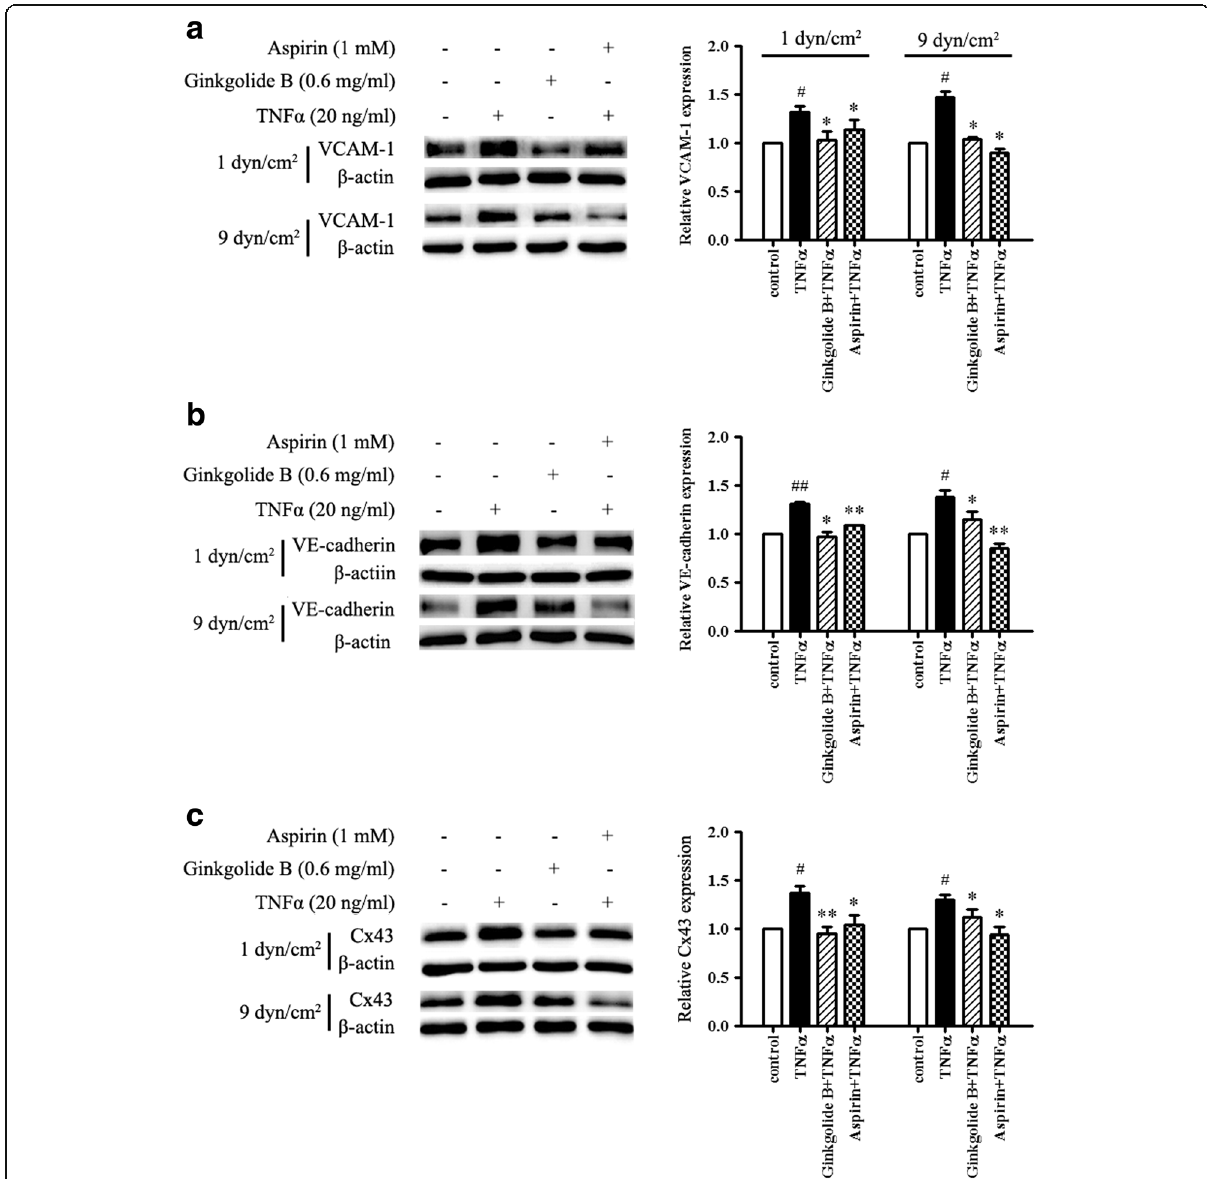
Fig. 2 Ginkgolide B suppressed VCAM-1, VE-cadherin, and Cx43 expression in TNF α -treated HUVECs that presented platelet adhesion under different conditions of laminar shear stress. HUVECs were incubated with ginkgolide B (0.6 mg/ml) or aspirin (1 mM) for 12 h, and then TNF α (20 ng/ml) was added for another 2 h. The platelet suspension was then added to the input well at 1 and 9 dyn/cm 2 of laminar shear stress for 45 min. Unadhered platelets were removed by the addition of PBS buffer for 2 min. Lysates were then collected by the addition of lysis buffer. Protein expression was analyzed by Western blot. The data were obtained from three independent experiments. a Ginkgolide B inhibited TNF α - induced VCAM-1 expression at 1 and 9 dyn/cm 2 . b Ginkgolide B decreased TNF α -induced VE-cadherin expression at 1 and 9 dyn/cm 2 . c Ginkgolide B reduced TNF α -induced Cx43 expression at 1 and 9 dyn/cm 2 . # p < 0.05, significant difference between TNF α -treated and -untreated HUVECs. ** p < 0.01, significant difference between TNF α -treated cells and ginkgolide B- and aspirin-treated